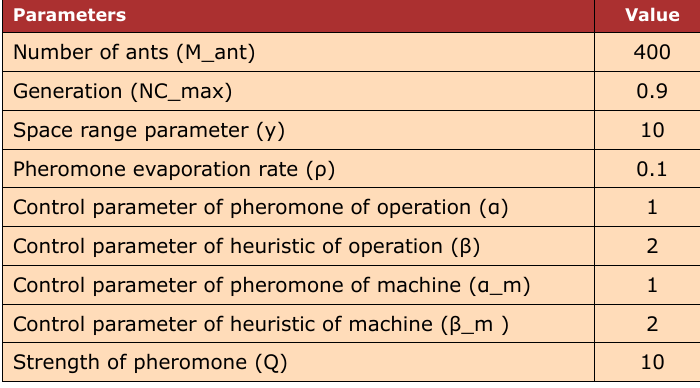
Table 2. Parameter of